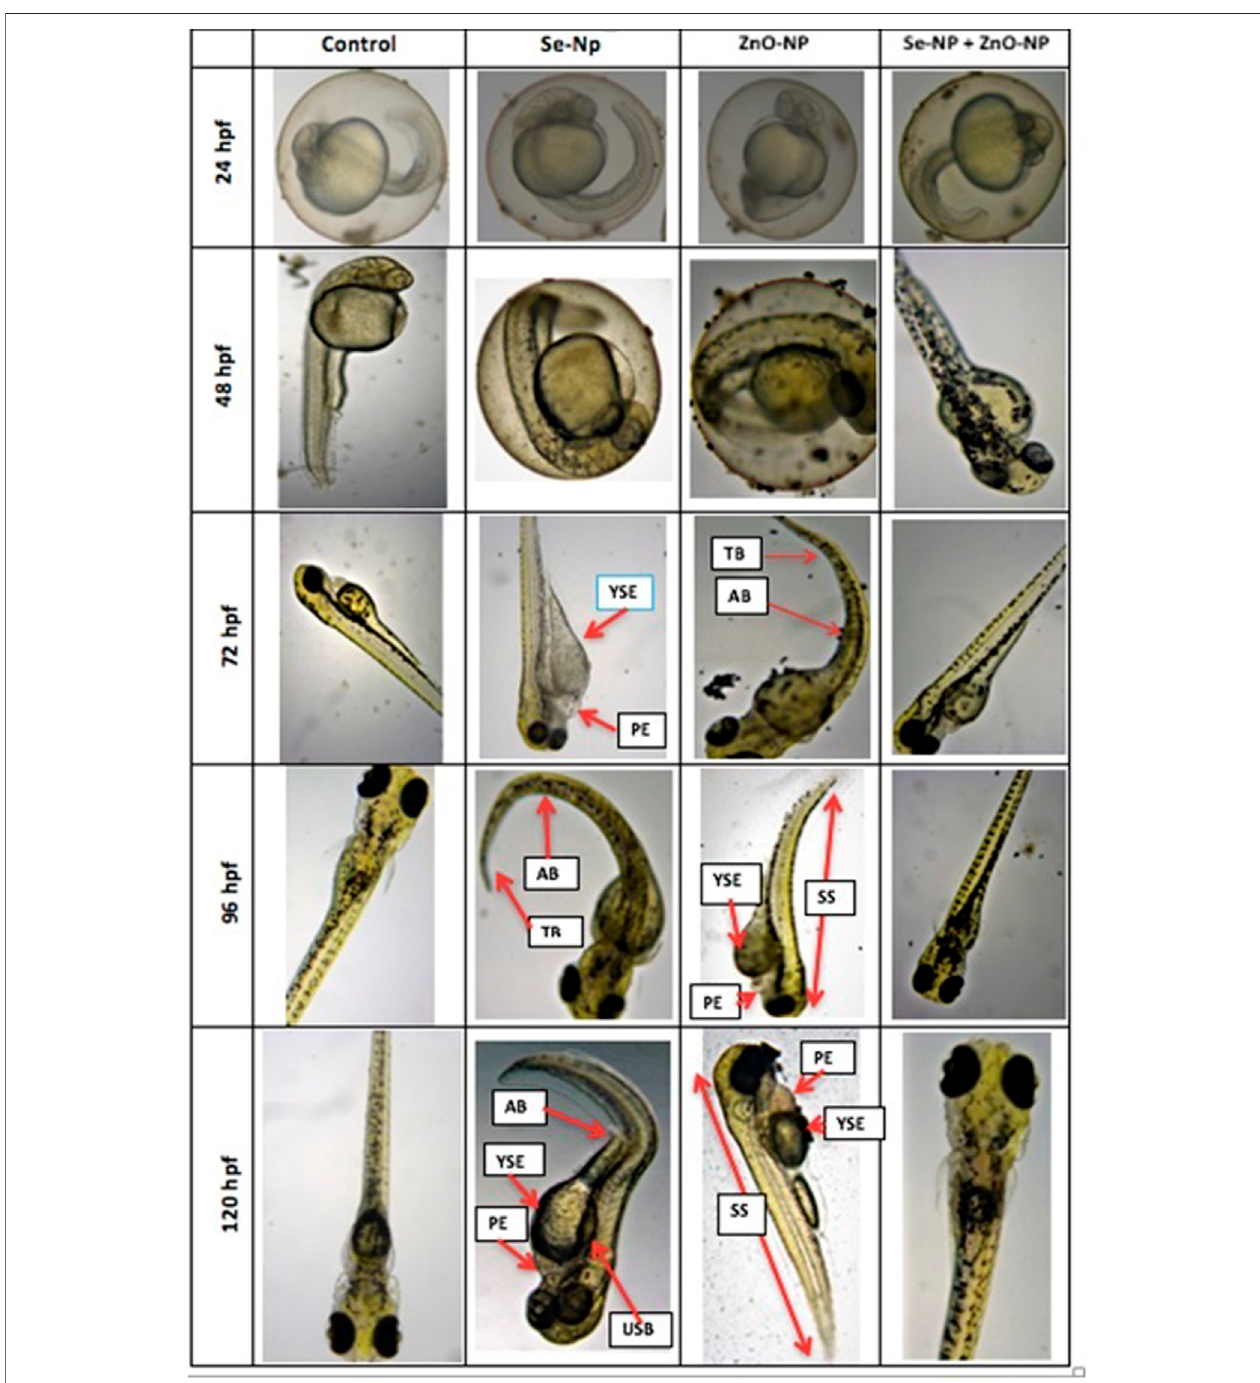
FIGURE5| Morphologicalanalysisofzebra fi shembryosobtainedfromthefourdifferentgroups(Control,SeNPs,ZnONPs,andSeNPs+ZnONPs).Thestructural deformities are shown in arrows: SC: spinal curvature, TM: tail malformation, PE: pericardial edema, YSE: yolk sac edema, USB: unin fl ated swim bladder, AX: axis (scoliosis), TB: tail bending, and SS: small size (dwarf).